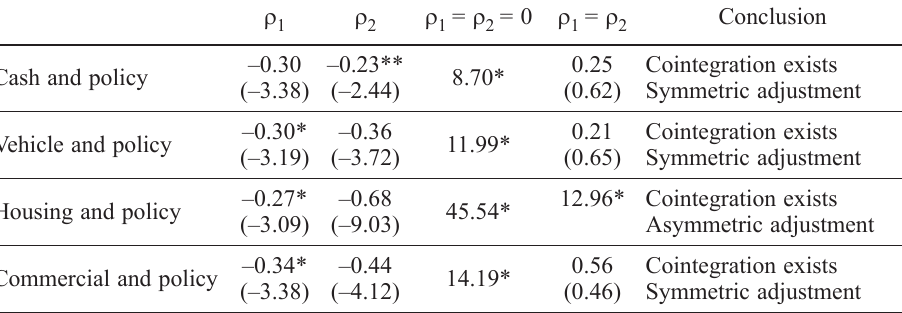
Table 4. Tests of cointegration and symmetric adjustment according to TAR model ( τ =